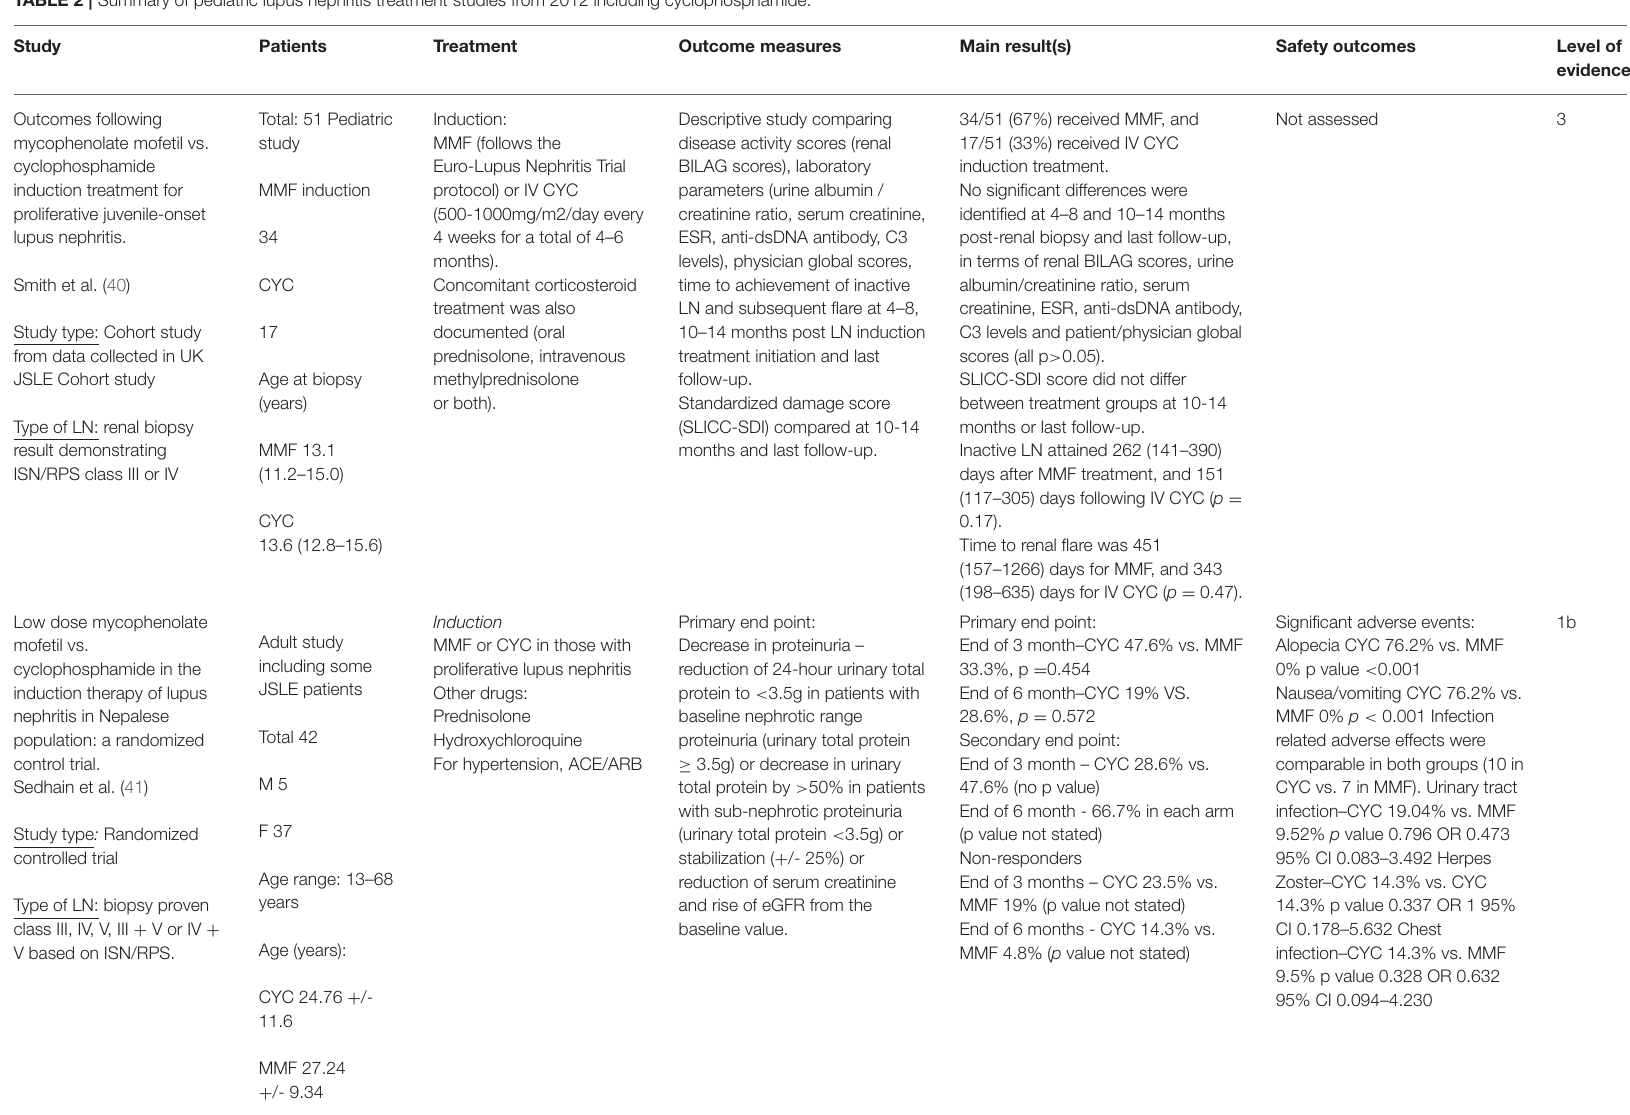
TABLE 2 | Summary of pediatric lupus nephritis treatment studies from 2012 including cyclophosphamide. Study Patients